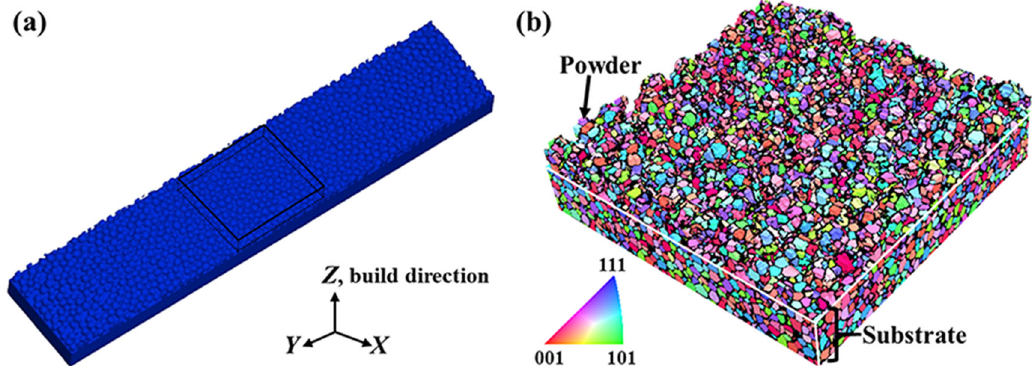
Fig. 1 Initial states. a Initial powder bed geometry in the TFF simulation; b initial grain morphology in the 1 st powder layer and substrate in the PF simulation. The black box in a shows the PF simulation domain (350 × 350 × 146 μ m 3 ) inside the whole domain of the TFF model (2 × 0.4 × 0.2 mm 3